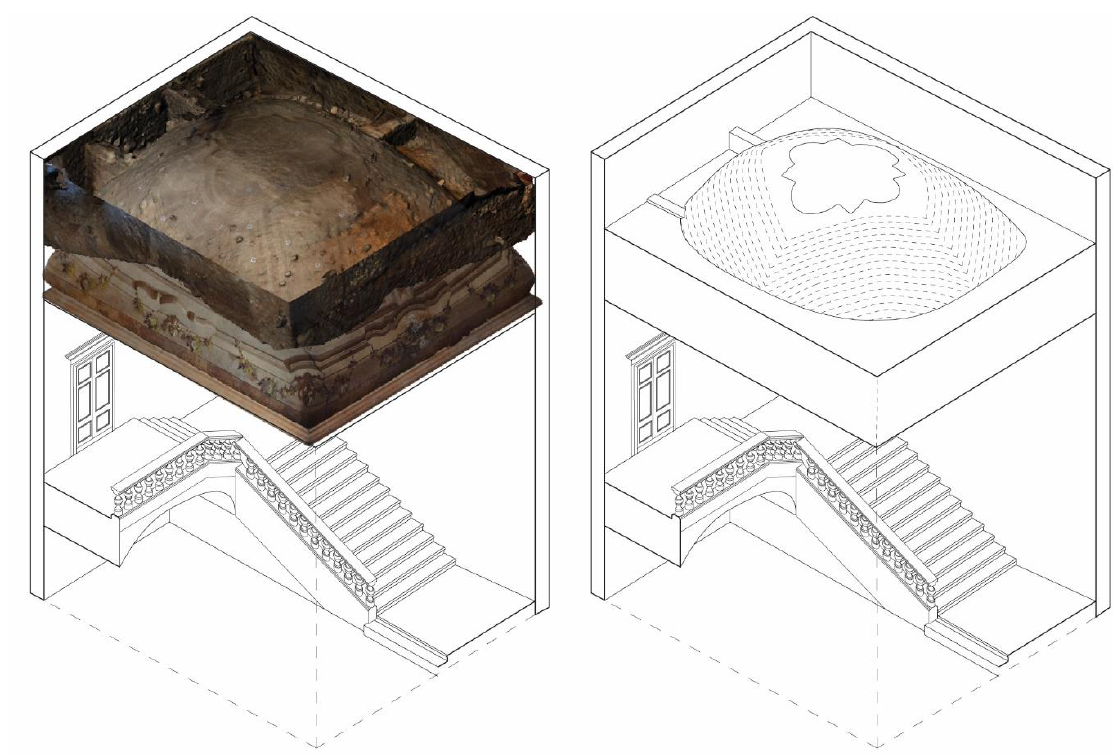
Figure 5. Axonometric view of the staircase room showing the overlapping of two 3D georeferenced orthoimages of the vault - intrados and extrados - that allows to better understand the arrangement of the